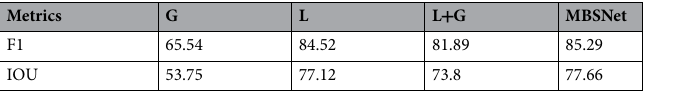
Table 5. Ablation study of our proposed multi-branch, where G represents that only branch G is experimented with, and so is L. L + K refers to the result after removing the FCFB experiment in MBSNet.